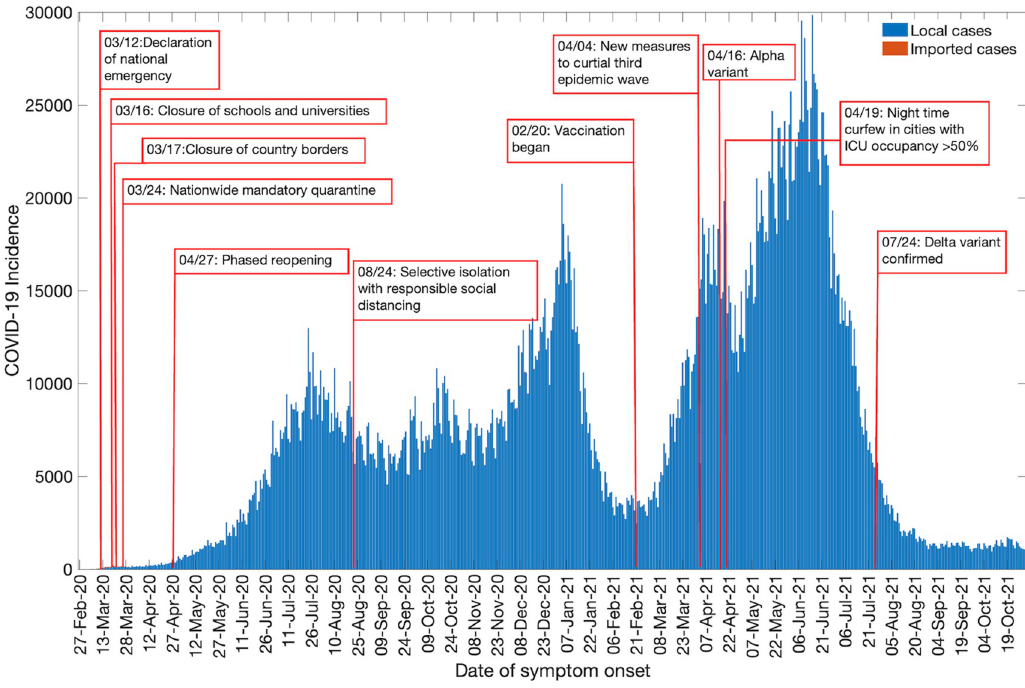
Fig 2. Epidemic curve of the COVID-19 pandemic in Colombia as of October 31, 2021.